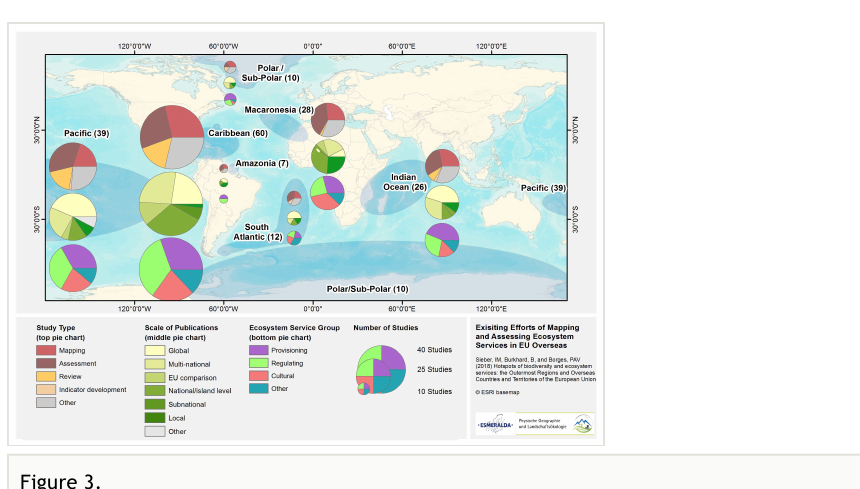
Geographical location of ES mapping and assessment studies in ORs and OCTs. All publications (n=161) obtained between April and June 2017 are included and divided by global regions. The map shows the number of case studies per region (number in brackets), their study type (top pie charts), scale of publication (middle pie charts) and group of ES assessed (bottom pie charts). Assessments at national or larger spatial scales are included in the map.